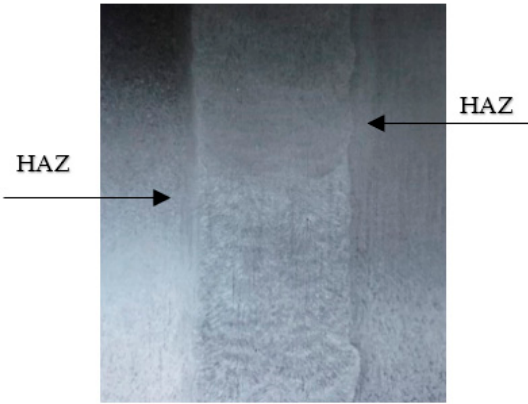
Figure 5. Macrostructure of the welded joint of the prototype rotor.